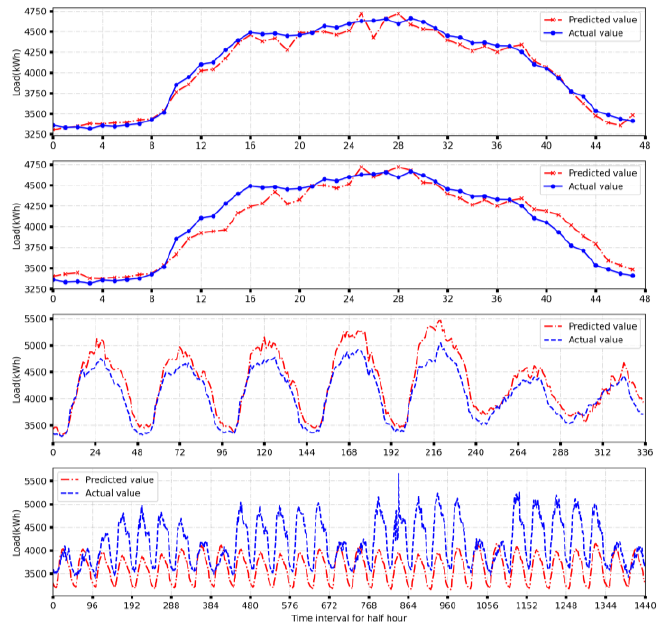
Figure 10. Prediction results for LSTM in four prediction scenarios. Predicted and actual load demand in USTLP scenario for 21 September 2021 ( first row ); Predicted and actual load demand in STLP scenario for 21 September 2021 ( second row ); Predicted and actual load demand in MTLP scenario for the period 11 October 2021–17 October 2021 ( third row ); Predicted and actual load demand in LTLP scenario for the period 1 May 2021–30 May 2021 ( fourth row ).